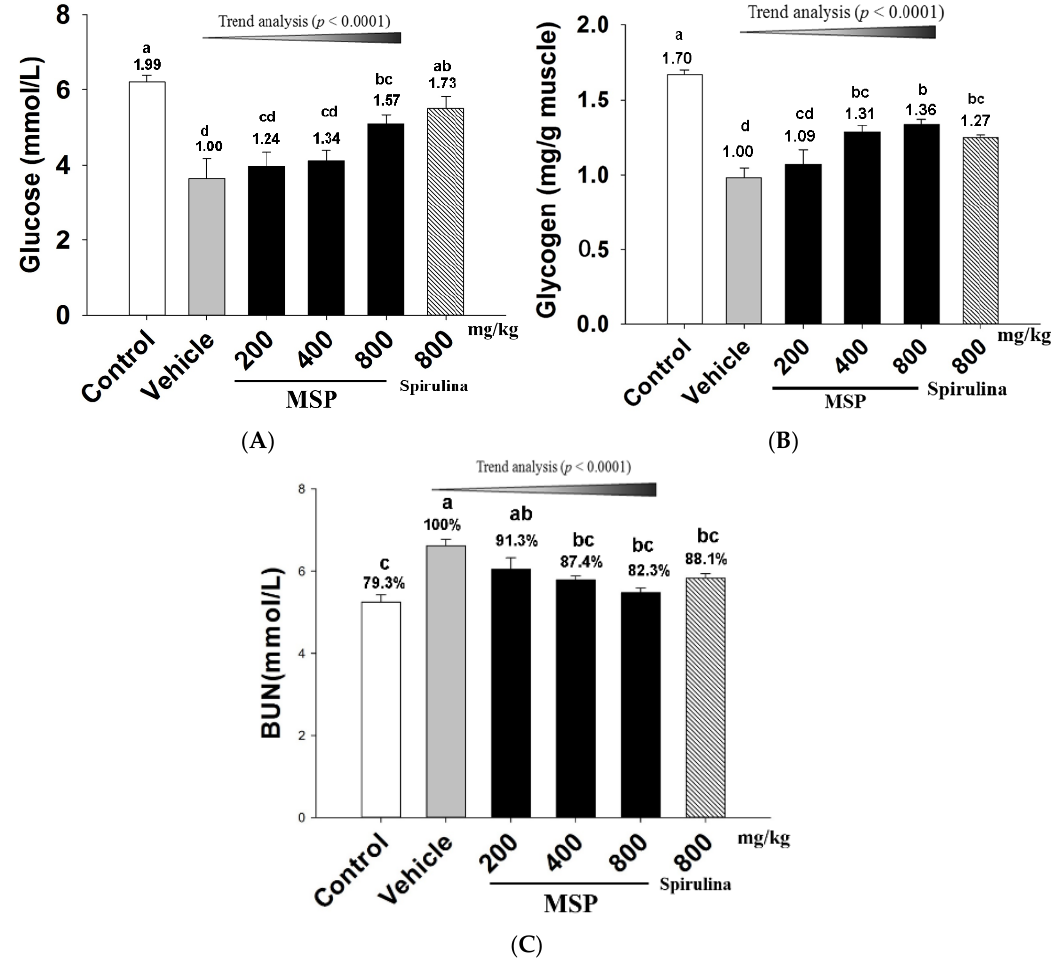
Figure 2. Effect of Millettiae speciosae Champ. total polysaccharides (MSP) on the level of plasma Glu ( A ); muscle glycogen ( B ) and blood urea nitrogen (BUN) ( C ) in mice after swimming for 30 min. Control group (open column), vehicle group (grey column), MSP ‐ treated group (200, 400, 800 mg/kg/day, black column), spirulina group (800 mg/kg/day, twill column). Data are mean ± standard error of the mean (SEM) for n = 8 mice per group. Bars with different letters (a, b, c, d) denote significantly different at p < 0.05. Numbers and percentages above the bars are the fold or percentage to the vehicle treatment.